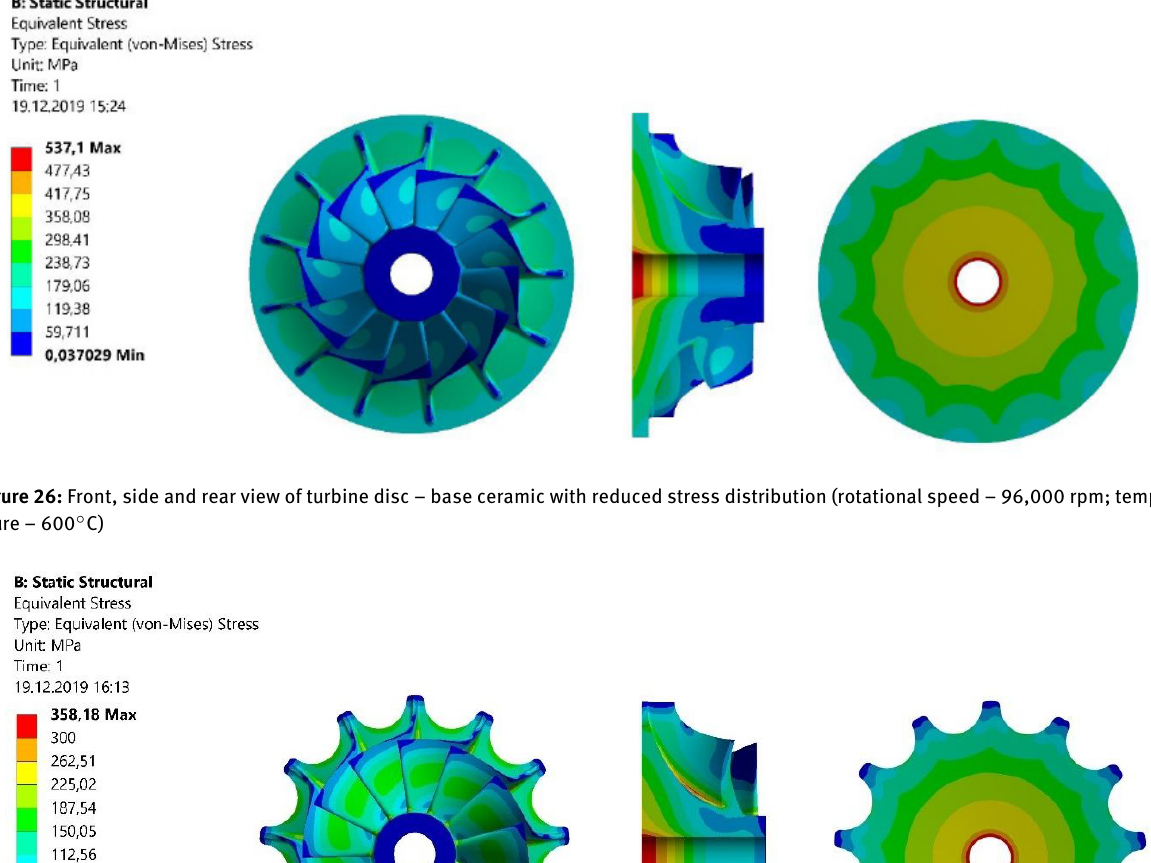
cal to the base disc, based on the developed algorithm, and the material was changed to silicon nitride (Si 3 N 4